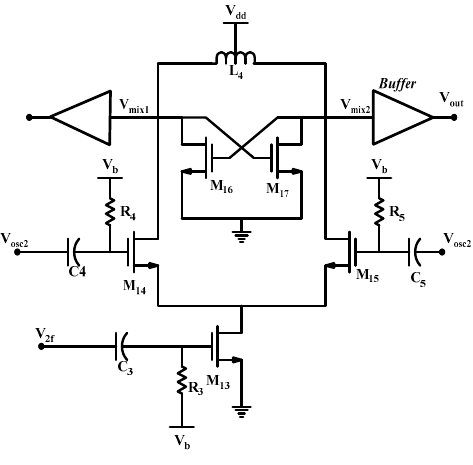
Figure 7. Circuit of the triple frequency.